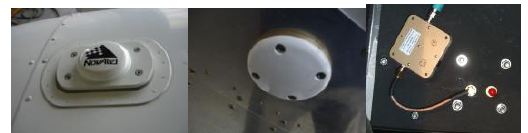
Figure 7. RHCP antenna (left), LHCP antenna (middle) and low noise amplifier (right).